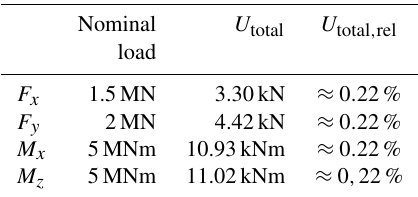
Table 3. Expanded measurement uncertainty for each measure-